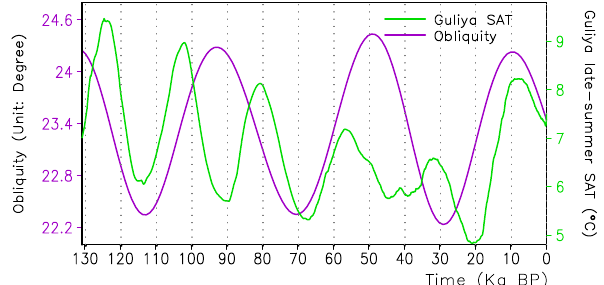
Fig. 7 . Simulated August–September Guliya SAT (green; right ordinate) and Fig. 7. Simulated August–September Guliya SAT (green; right or- obliquity (purple; left ordinate) in the past 130 ka. dinate) and obliquity (purple; left ordinate) in the past